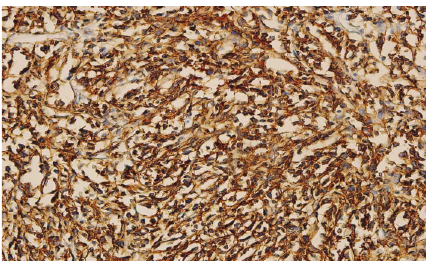
Figure 2: Paraffin immunostaining studies showed strong positivity of the neoplastic cells for B-cell CD20.